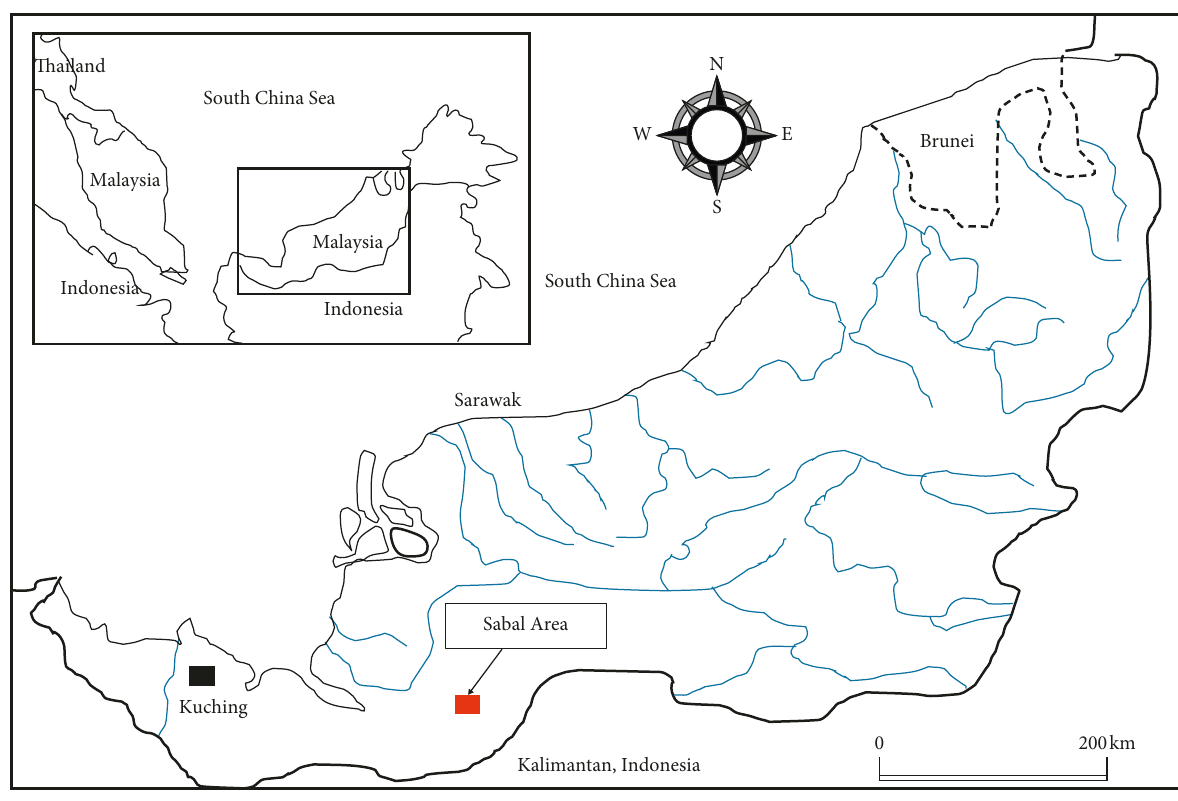
Figure 1: Map of the study area.